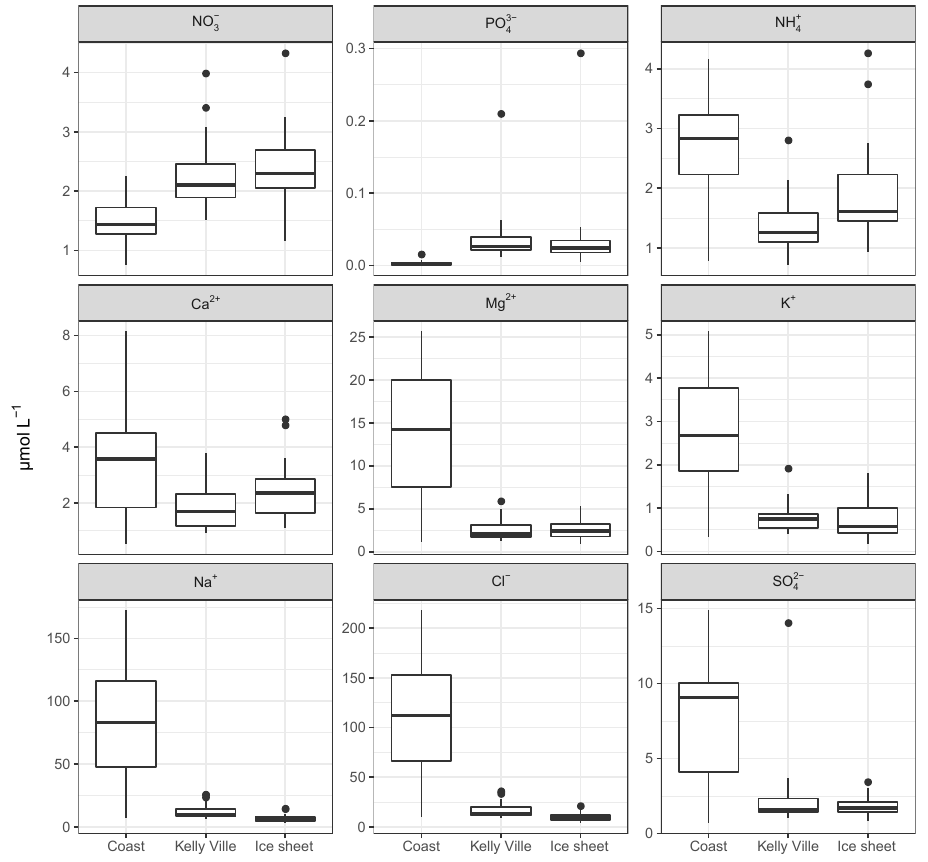
Figure 3. Comparison of regional snowpack ion concentrations (aggregated data – n = 24 per region; all units in µmolL − 1 ) . Boxes represents 25th and 75th percentiles, horizontal line indicates the median, whiskers are drawn to the extents of the data or to 1.5 times the interquartile range (IQR) beyond the limits of the box and observations that lie further than 1.5 times the IQR beyond the box are indicated by points.